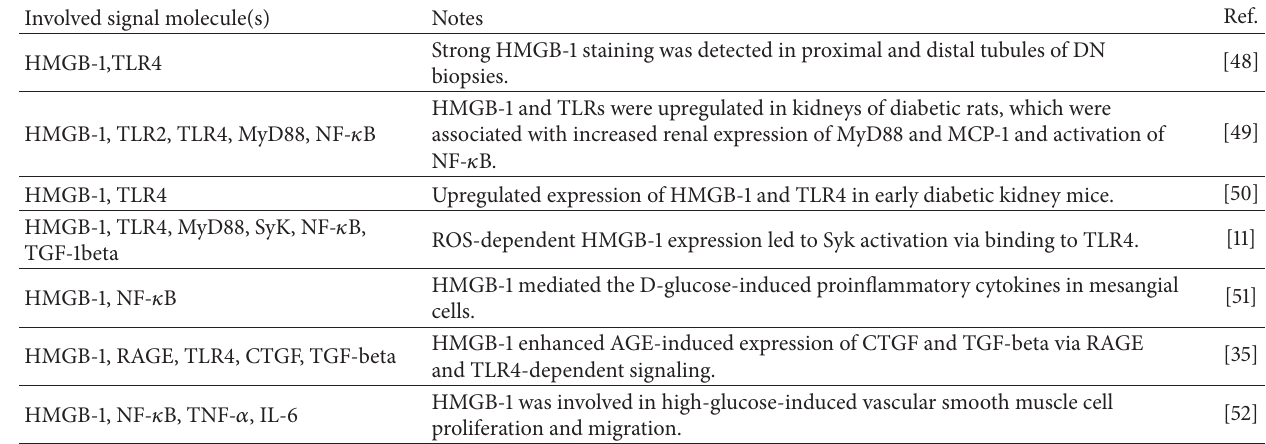
Table 2: HMGB-1: evidence in DN (diabetic